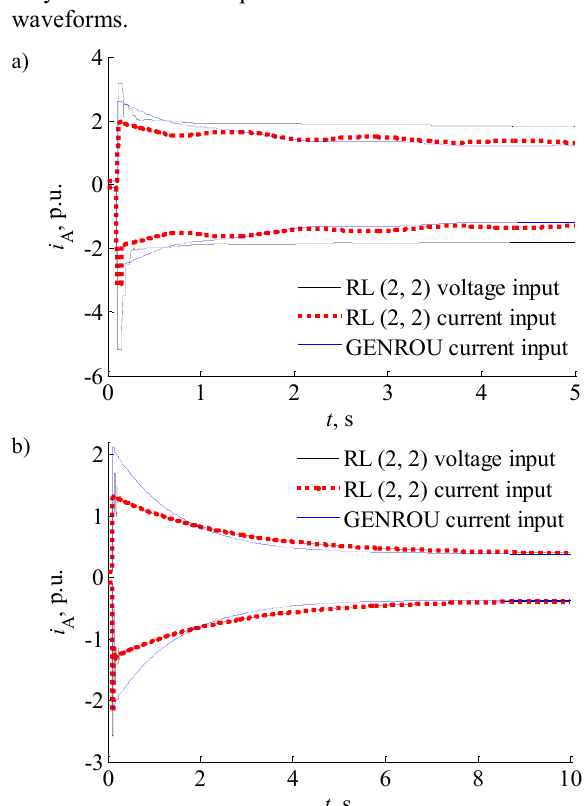
Table 1. Amplitudes of harmonics in the analyzed waveforms. 2-phase short-circuit h